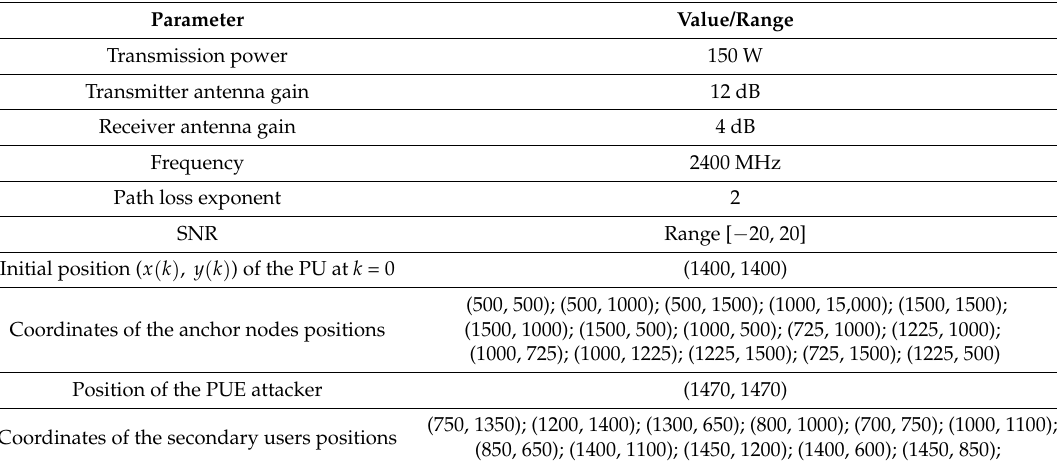
Table 1. The simulation